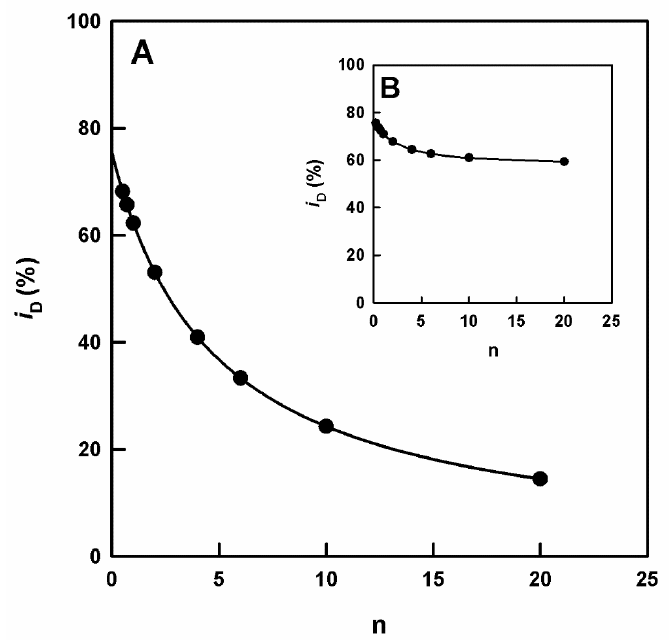
Figure 8. ( A ) Solution of the ambiguity between competitive and mixed type (1) inhibition. Repre- sentation of i D vs. n. The simulation conditions were the same as in Figure 6A,B, but the inhibitor concentration [ I ] was constant (100 µ M). The substrate concentration (mM) was varied: 0.25, 0.35, 0.5, 1, 2, 3, 5 and 10. The adjustment by non-linear regression ( i C vs. n), according to Equation (S17), allows us to obtain K app (K app I 1 I 1